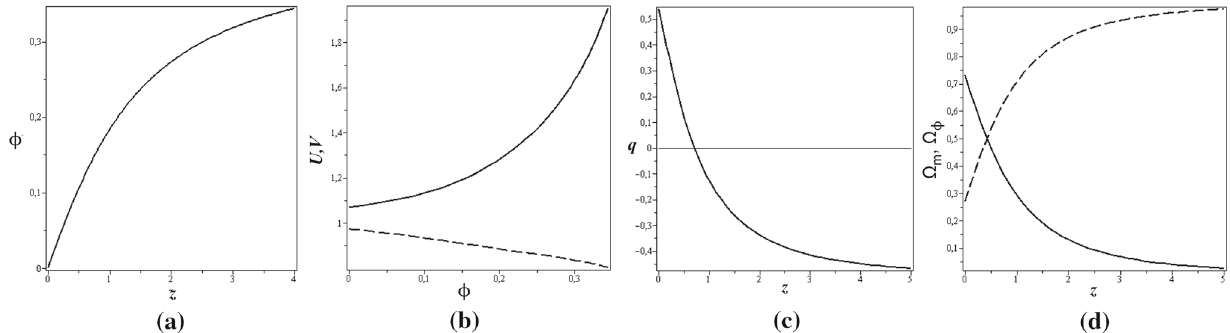
φ = 0, H = 1, ω = − 0 . 95, ω = 0 . 1 and 0 0 0 1